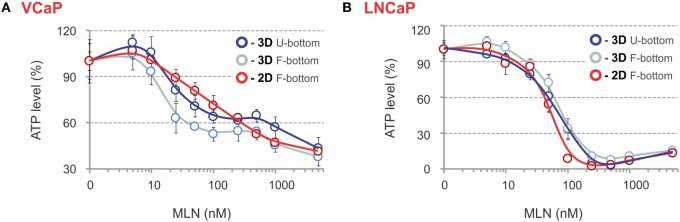
ATP-based endpoint assay to assess the MLN effect. (A,B) Spheroids were preformed (A) for 7 days with 2,000 VCaP cells and (B) for 4 days with 500 LNCaP cells and treated for 4 days (VCaP) or 2 days (LNCaP) with the indicated concentrations of MLN. Then, the spheroids were lysed with ViaLight™ reagent, and luminescence was measured directly in the U-bottomed 96-well NTA plate using a GloMax®-Multi Detection System (dark blue curves, 3D U-bottom). Then, the spheroid lysates were transferred into a white plate with a flat transparent bottom (Greiner Bio-One), and luminescence was remeasured (light blue curves, 3D F-bottom). In parallel, VCaP (100,000 cells seeded) and LNCaP (20,000 cells seeded) monolayer cultures in white microtiter plates with a flat transparent bottom (Greiner) were processed similarly with ViaLight™ reagent and analyzed (red curves, 2D F-bottom). The data were normalized to the mean value obtained under control conditions (MLN = 0 nM) and are plotted as the means ± SD (six replicates per condition, per plate).